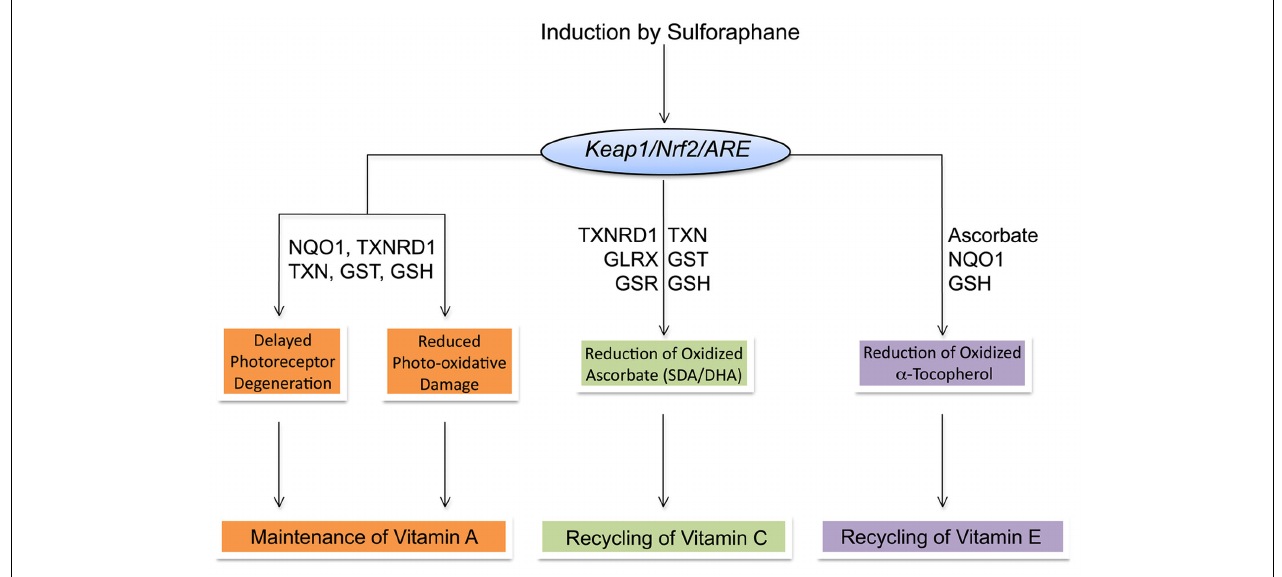
FIGURE 3 | Summary of interactions and maintenance of vitaminsA, C, and E by Sulforaphane-mediated induction ofARE-dependent gene products.